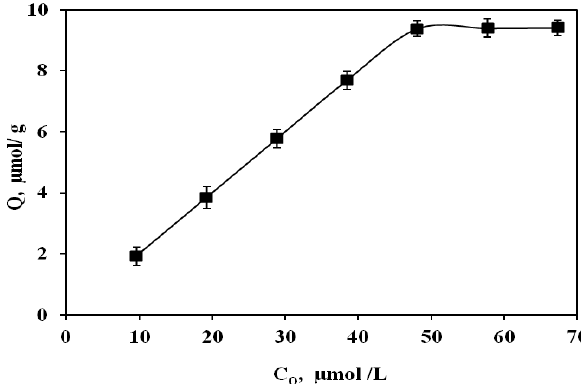
@Cr(VI)-IIL for Cr(VI) in 2